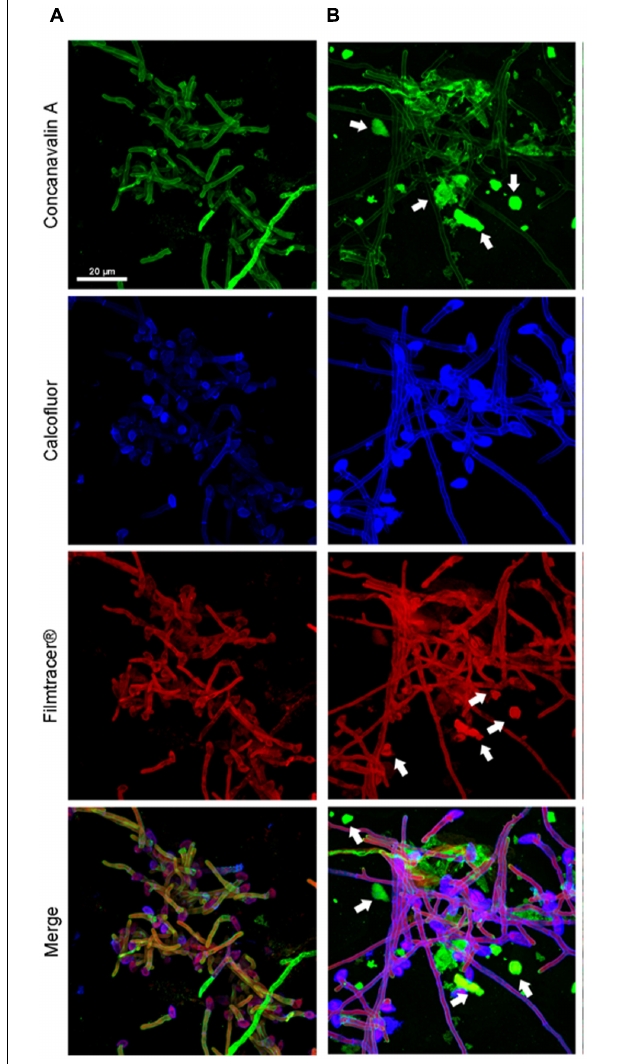
FIGURE 4 | Confocal microscopy of a S. aurantiacum biofilms grown for 6 h in vitro . (A) S. aurantiacum CBS 136046 and (B) S. aurantiacum CBS 136047. In the panels, glucose-mannose residues were stained using concanavalin A-Alexa 488 (green panel), cell walls and matrix chitin were stained using calcofluor white (blue panels) and glycoproteins were stained using the biofilm-tracer FilmTracer R (cid:13) Sypro ruby (red panels). White arrows indicate accumulated extracellular matrix. The same magnification (63 × ) was used in all